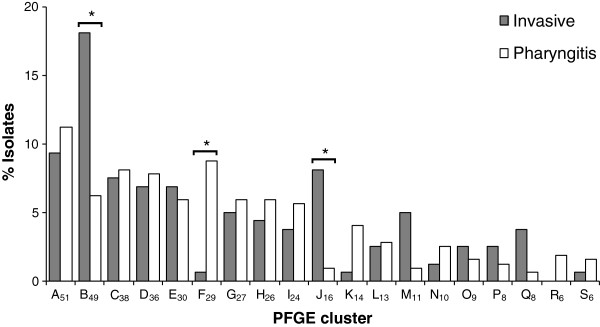
PFGE clusters found among 160 invasive isolates and 320 pharyngitis isolates. Approximately 11% of invasive and 16% of non-invasive isolates were included in PFGE clusters of ≤ 5 isolates that are not represented. The asterisk indicates significant differences (P<0.001).